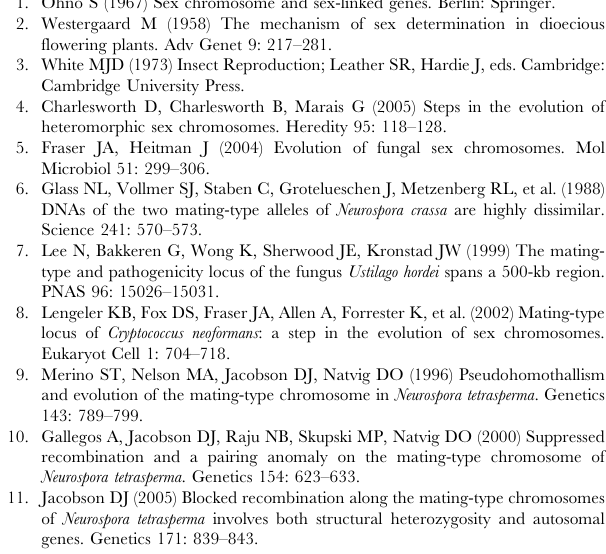
Multiple Strains of N. tetrasperma